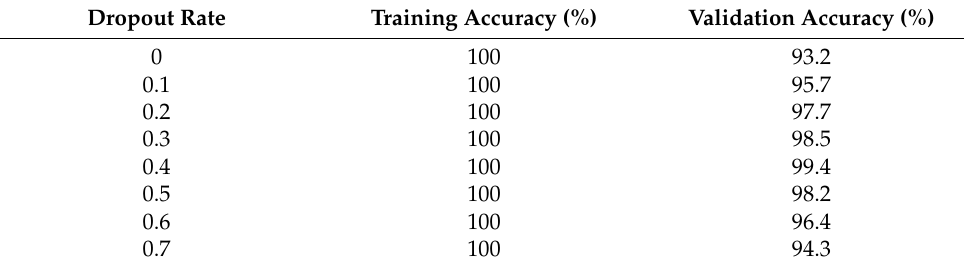
Table 1. Classification accuracy of different dropout rates.